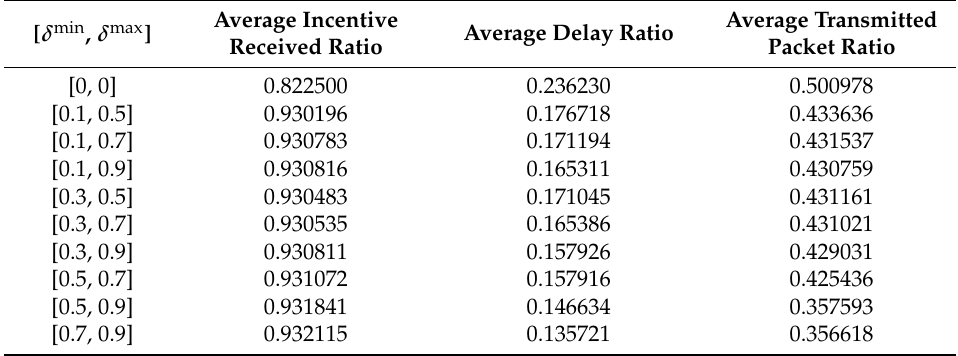
Table 4. The impact of δ on the performance of